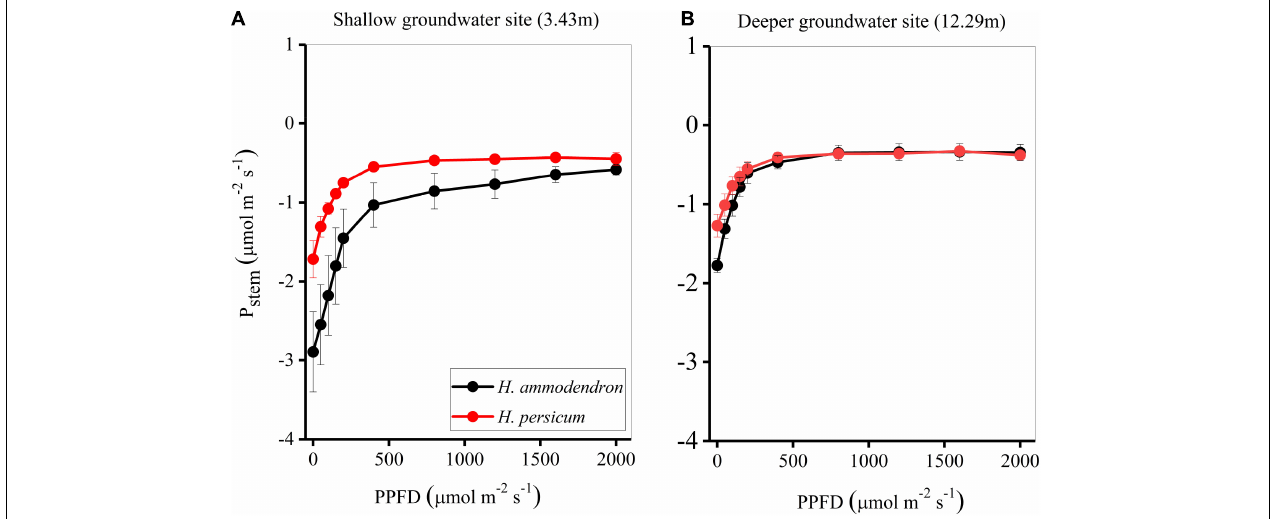
FIGURE 4 | Photosynthetic light responses as measured in situ for stems (A,B) of the two Haloxylon species at two sites. Values are means of three replicates ± SE of the mean.